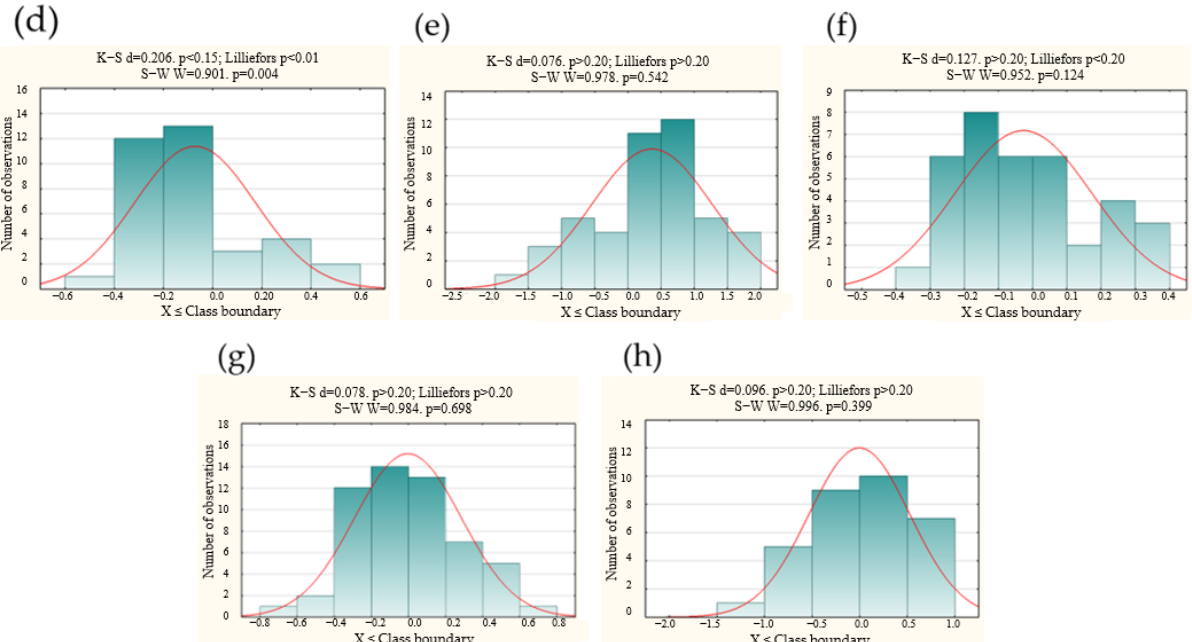
Figure 5. Histograms presenting the normal distribution of the accuracy of GPR detection (concerning three survey methods) for specific test periods: ( a , b ) the 1st measurement period; ( c ) the 2nd measurement period; ( d , e ) the 3rd measurement period; ( f , g ) the 4th measurement period; ( h ) the 5th measurement period. Histograms ( a , c , d , f ) refer to method 1, ( b , e , h ) to method 2, and ( g ) — to method 3.